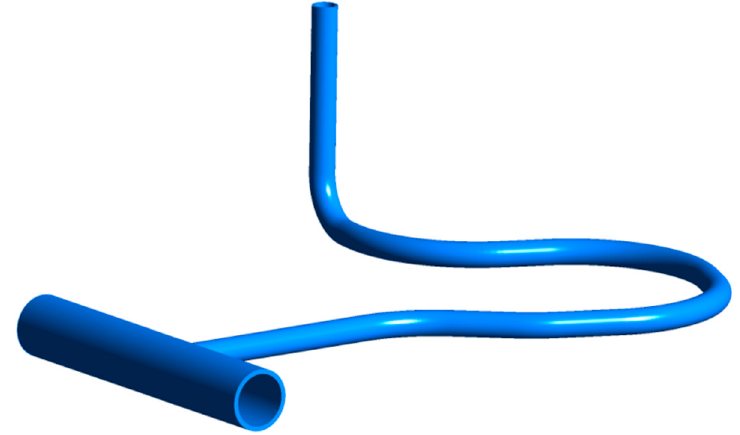
Figure 1. The 3-D model of the surge line. Solid 185 element was used to mesh the surge line and there were 302,880 elements in the finite element model as shown in Figure 2.